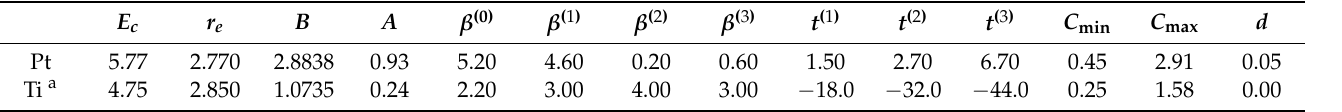
Table 1. Finalized 2NN MEAM interatomic potential parameters for the pure Pt and Ti. The units of cohesive energy ( E c ), equilibrium nearest-neighbor distance ( r e ), and bulk modulus ( B ) are eV/atom, Å, and 10 12 dyne/cm 2 , respectively. Other parameters are unitless. The reference structures used are fcc and bcc for pure Pt and Ti, respectively.